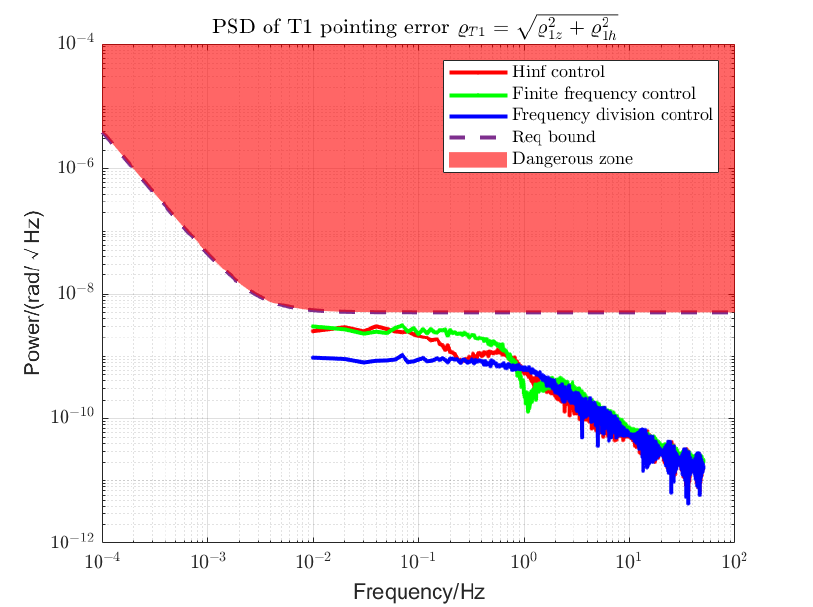
Figure 12. PSD of T1 LOS pointing error. The red area above the dotted line is a hazardous area that exceeds the specified limits. The control performances of the loop-shaping control, finite frequency control, and frequency division control are